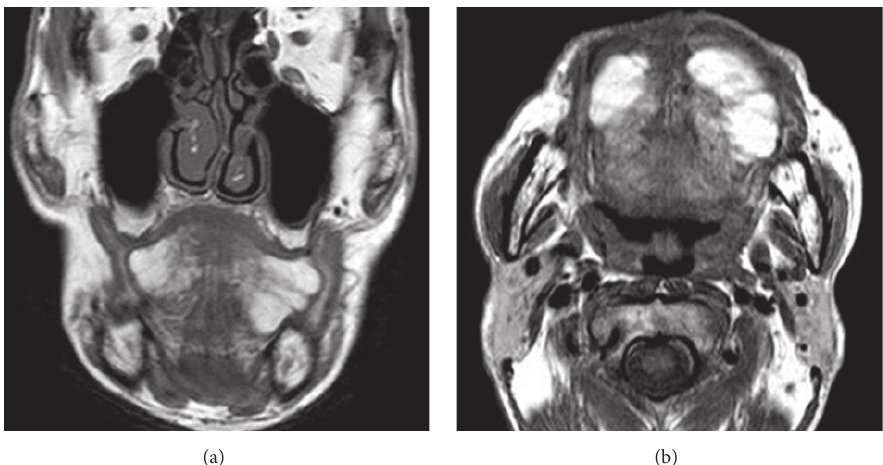
Figure 2: MR images ((a) axial view, (b) horizontal view). MR imaging shows high-intensity nodules and adipose tissue invading into the bilateral lingual